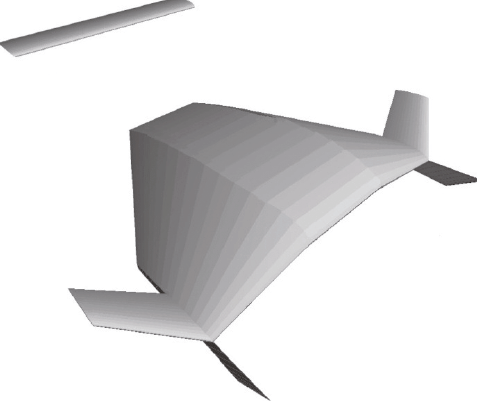
Figure 3: Hypothetical WIG craft used for the Table 1: Main geometrical characteristics of the WIG craft used in the calculations.